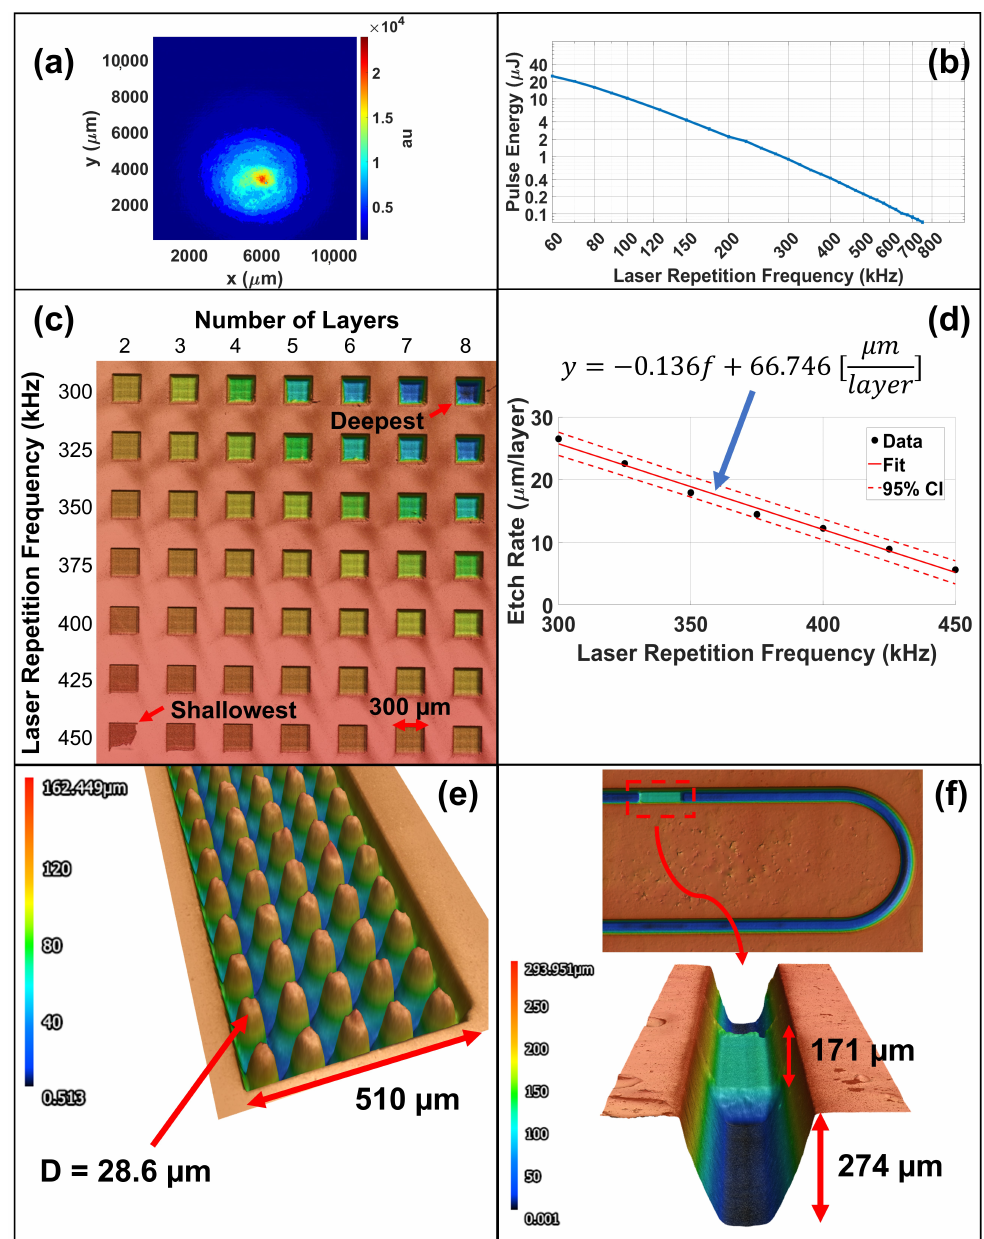
Figure 5. Femtosecond UV Laser Characterization—illustrates laser and etch rate characterization. ( a ) shows the measured beam profile at the lens (which is equivalent to at laser focal plane without the 125 mm galvo focusing lens). The beam diameter at the focal plane was calculated to be 8.83 µ m from Gaussian beam theory. ( b ) shows the pulse energy as a function of laser repetition frequency. ( c ) shows the etch rate characterization test samples in which 300 × 300 µ m 2 squares were etched using a cross-hatch line spacing of 3 µ m. ( d ) describes the etch rate as a function of laser repetition frequency enabling controllable milling of micro-channels. ( e , f ) highlights the ability to fabricate 2.5D micro-structures through controllable milling. ( e ) shows a repeating tapered micro-pillar array of diameter D = 28.6 µ m inside a 510 × 126 µ m 2 channel. ( f ) shows an integrated step height 171 µ m from the top channel surface inside a 306 × 274 µ m 2 channel demonstrating 2.5D milling